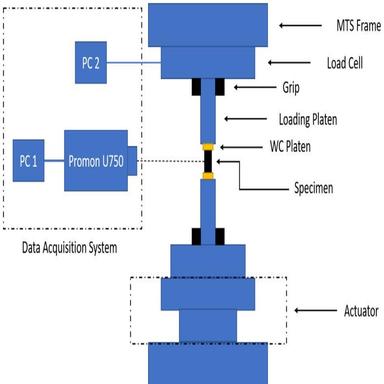
Schematic of the MTS machine experimental setup.